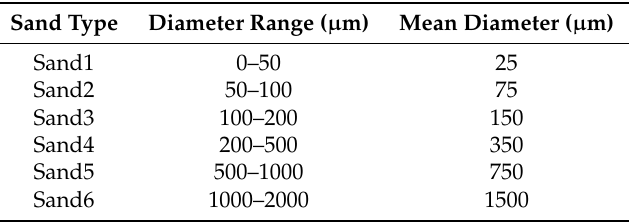
Table 1. The particle grain-size classes of Regional Ocean Modeling System (ROMS) hydro-sedimentary